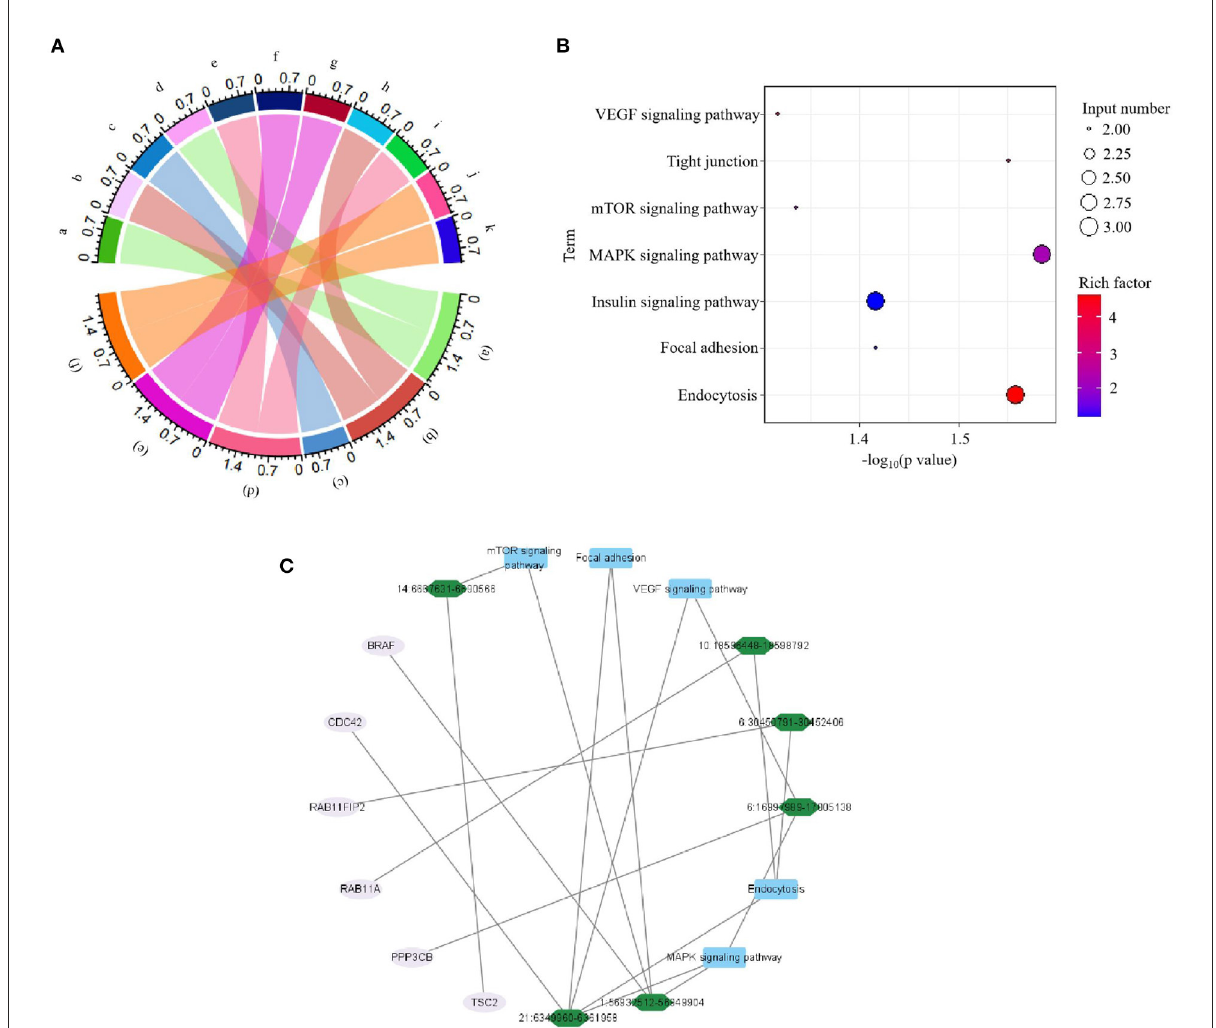
FIGURE3 Functional analyses of source genes of differentially expressed (DE) circRNAs in the comparison of avian pathogenic E. coli infected HD11 cells (APEC) vs. wild type HD11 cells (WT). (A) Gene classification was based on Gene Ontology (GO) analysis of source genes of DE circRNAs. a. BRAF ; b. BCL2L13 ; c. RAB11FIP2 ; d. YBX3 ; e. CLOCK ; f. FLOT1 ; g. ITSN2 ; h. PPP1R13B ; i. PPP3CB ; j. TSC2 ; k. MTMR9 ; (a). positive regulation of gene expression; (b). apoptotic process; (c). phagocytosis; (d). positive regulation of inflammatory response; (e). positive regulation of endocytosis; (f). regulation of autophagy. (B) The significantly changed KEGG pathways in the comparison of APEC vs. WT. (C) Visualization for the significant enrichment pathways and enriched genes of APEC vs. WT. The innermost squares with blue represent the five significantly enriched pathways; The middle green layer represents enriched source genes; The outermost pink circles represent the identified DE